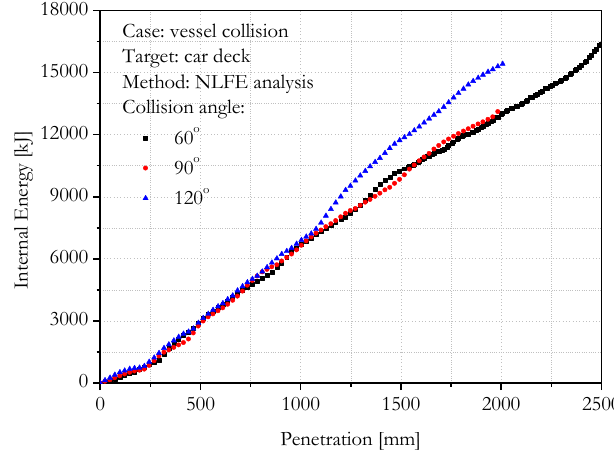
Figure 4. Summary of the internal energy based on the proposed cases.